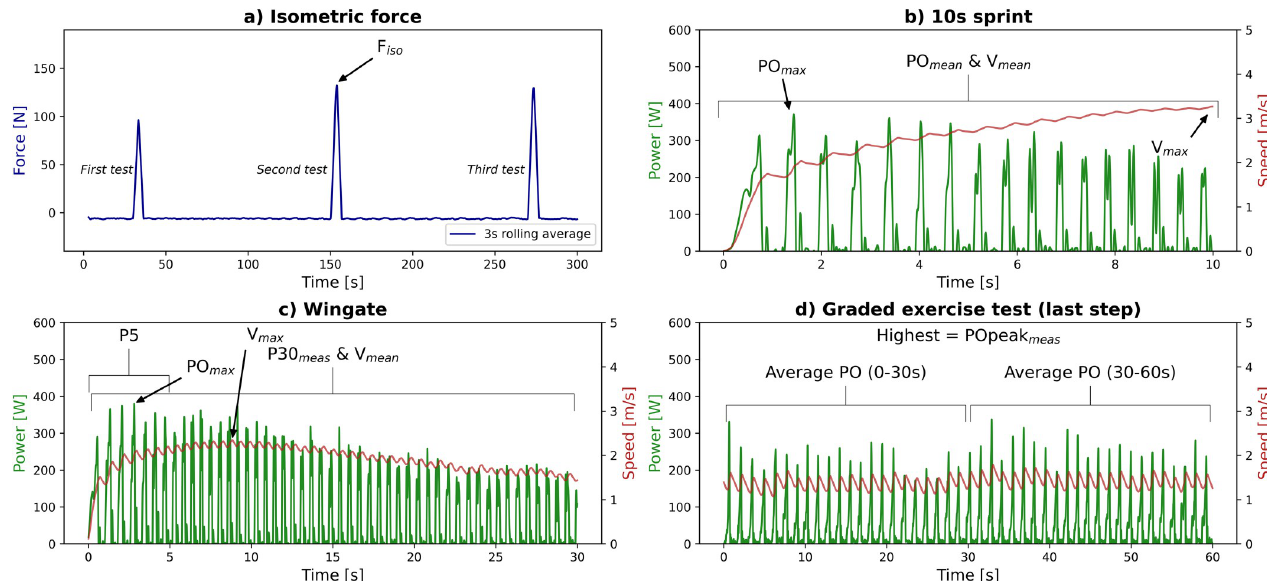
Fig 3. Extracted variables for the a) isometric strength test, b) sprint test, c) Wingate test and d) graded exercise test. Strength (F) is the average of both arms (in blue); power output (PO) is the sum of both arms (in green); velocity (v) is the average of both arms (in